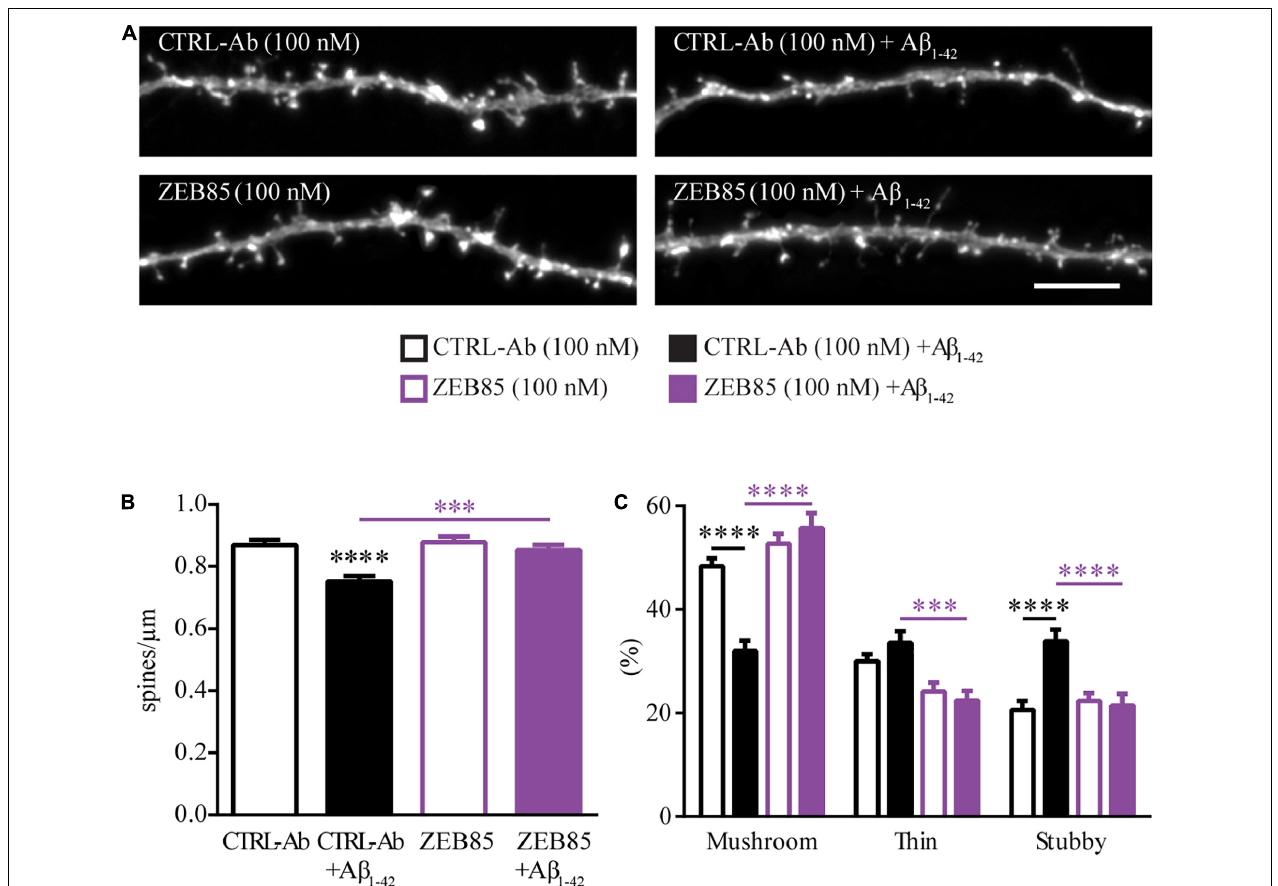
FIGURE 4 | ZEB85 rescues Amyloid beta1-42-induced spine loss. (A) Representative dendritic segments with dendritic spines from feGFP transfected hippocampal neurons either pretreated with ZEB85 (100 nM) or control-antibody (CTRL-Ab) for 15 min, followed by a 6 h treatment with amyloid- β 1-42 or left further untreated. Scale bar, 5 µ m. (B) Quantification of spine density (CTRL-Ab and ZEB85: n = 47 dendrites/neurons; CTRL-Ab + A β : n = 49; ZEB85 + A β : n = 48). N = 3 independent experiments. The data are presented as mean ± SEM and were tested using a one-way ANOVA with Bonferroni post-test. (C) Quantification of spine type distribution ( n = 30; N = 3 independent experiments). The data are presented as mean ± SEM and were tested using a two-way ANOVA with Bonferroni post-test. ∗∗∗ p < 0.001; ∗∗∗∗ p < 0.0001.